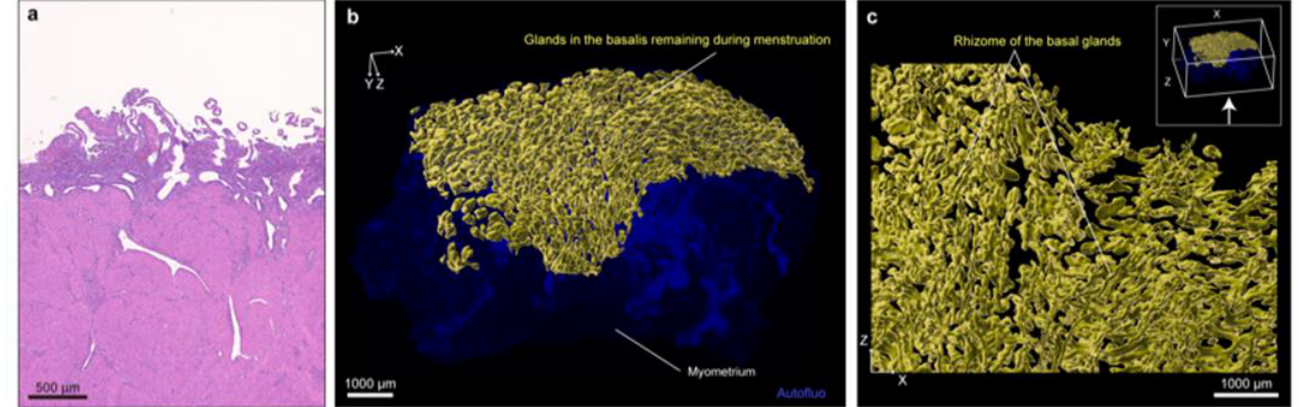
Figure 3. 3D morphology of endometrial glands in a case during menstruation (age 45). ( a ) H&E-stained image of FFPE endometrial tissue in a menstrual sample. ( b ) Reconstructed 3D image of the same sample shown in panel ( a ). Yellow object: glands in the basalis remaining during menstruation. ( c ) Extended XZ-plane view (view from the direction of the arrow in the upper right inset) of the same sample shown in panel ( a ). The yellow object shows the rhizome structure of the basal glands remaining during menstruation. Yellow objects were constructed by the Surface module in Imaris [29]. After surface extraction, each structure was manually curated, and extra surface signals were eliminated. Images were obtained by LSF microscopy. Autofluorescence was measured by excitation at 488 nm. Autofluo, autofluorescence. See also Video S2.